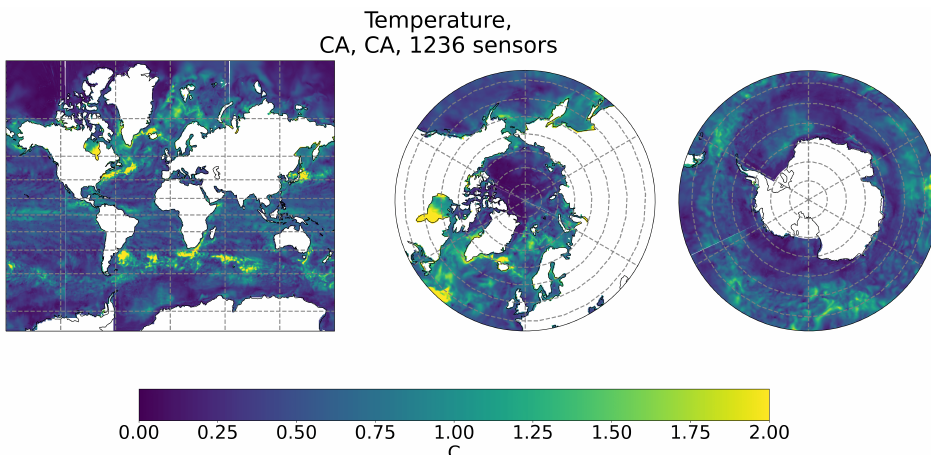
Figure 12. Spatial distribution of reconstruction bias from the climate without measurements.